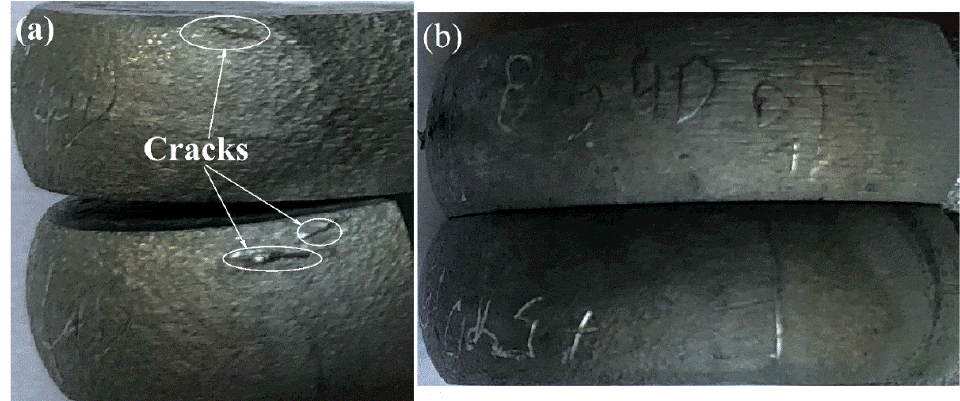
Figure 5. Image of the AlCuYMg1 and AlCuErMg1 alloys samples deformed at ( a ) 440 °C 15 s − 1 and ( b ) 540 °C 0.1 s − 1 .